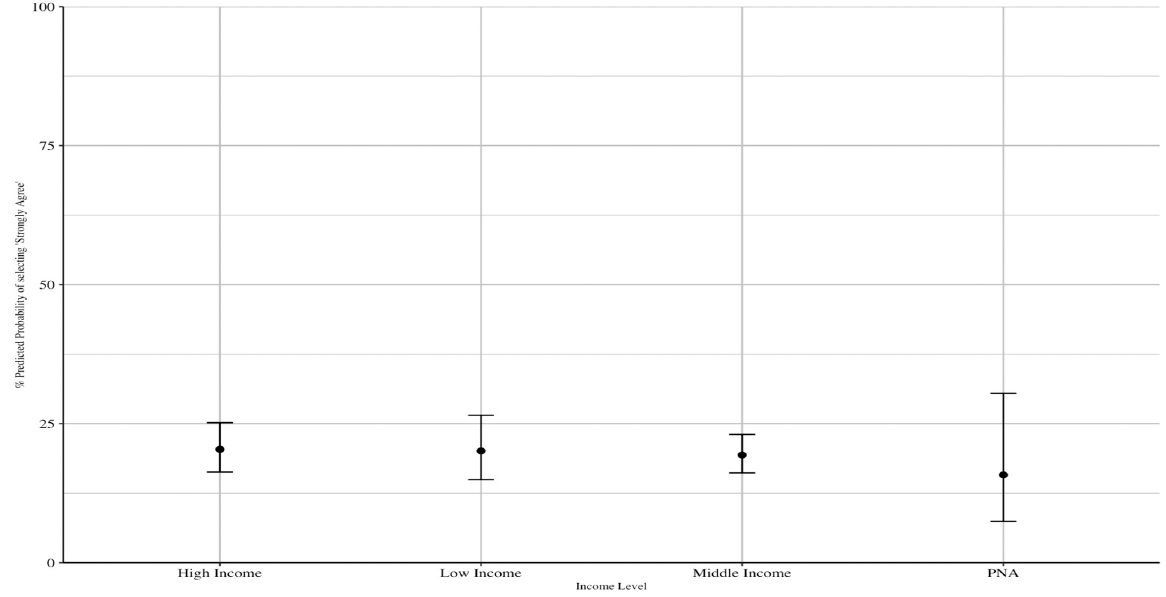
Figure 1. Predicted probability of selecting “Strongly Agree” to short-term health risks based on income level.